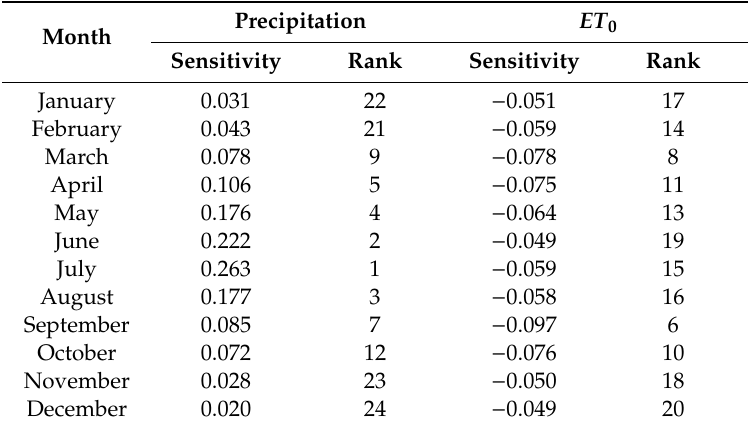
Table 5. Ranking of monthly precipitation and ET based on the sensitivity indices.